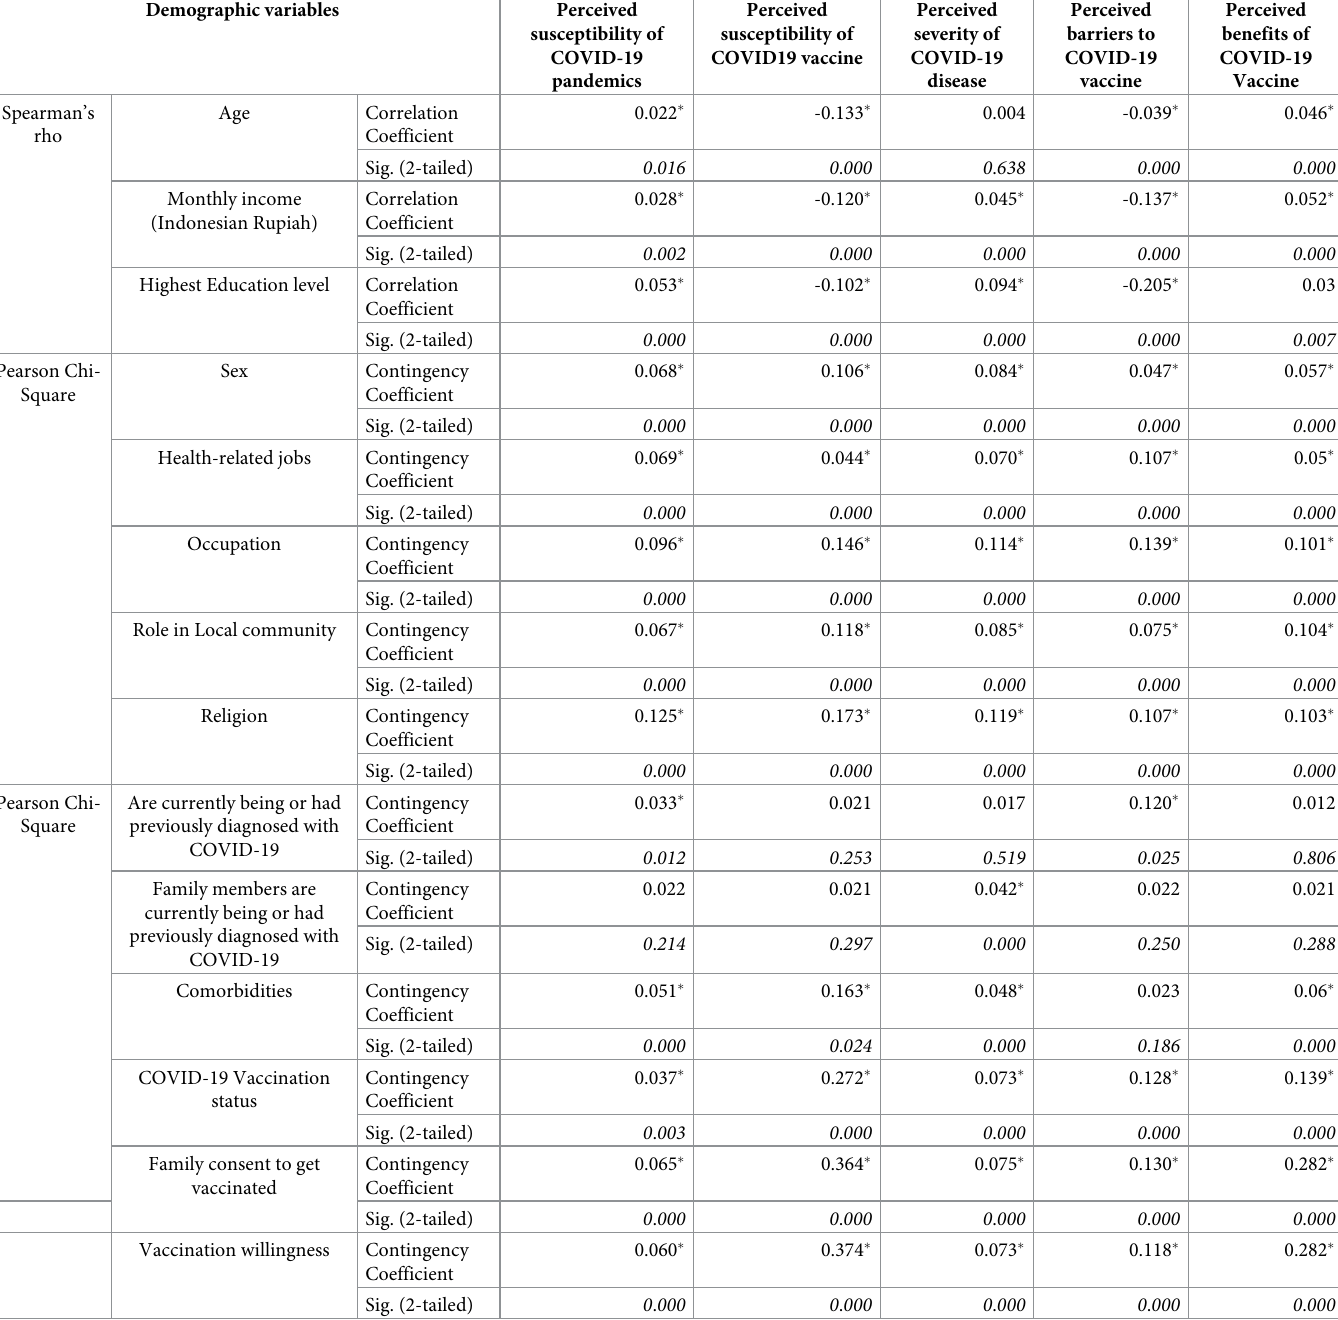
Table 2. Correlation between the extended demography variables and the HBM constructs. Demographic